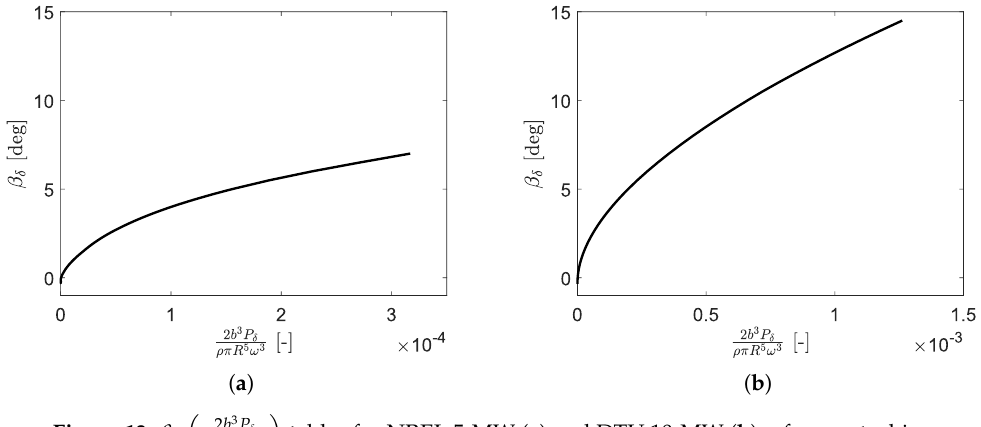
(cid:16) (cid:17) 2 b 3 P δ Figure 13. β δ tables for NREL 5-MW ( a ) and DTU 10-MW ( b ) reference ρπ R 5 ω 3